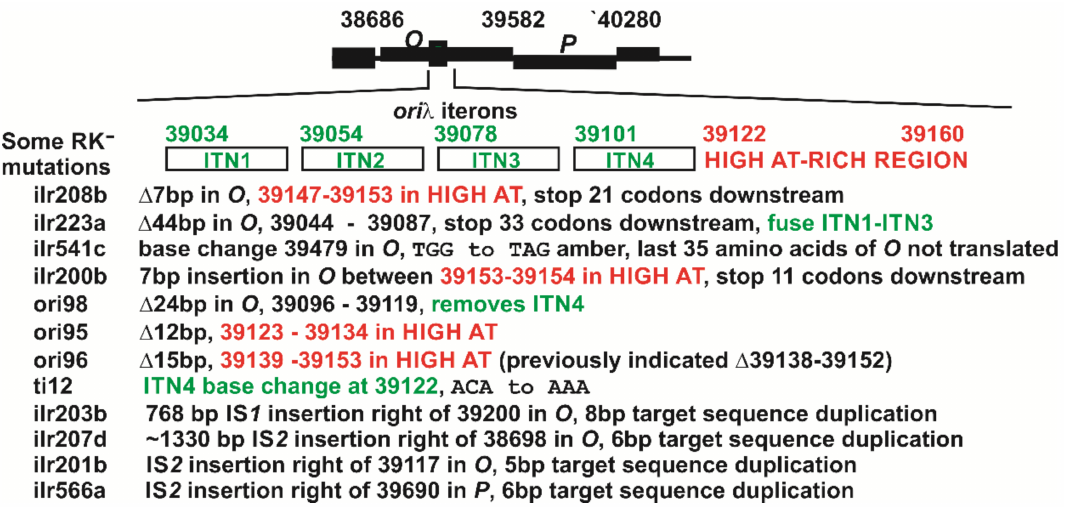
Figure 2. RK − ilr mutations characterized within λ genes O-P . The minimal ori λ size was suggested to include a HIGH-AT-rich region to the right of four iteron sequences, ITN’s1-4 [43,44], which each contain an 18 bp inverted repeat of hyphenated symmetry, joined by adenine residues that can cause ori λ to assume a bent structure [45]. The mutants shown designated ori95, ori96 and ori98 were obtained from WD from prophage with r -mutants r-95 , r-96 , and r-98 . Note that Denniston-Thompson, et al., [46] sequenced the r -mutants r-99 , r-96 and r93 which represent ∆ 12 bp (39120–39131), ∆ 15 bp (39138–39152) and ∆ 24 bp (39092–39115) [42]. Our sequence localization for ori96 ( r96 ) differs by one bp from that assigned in